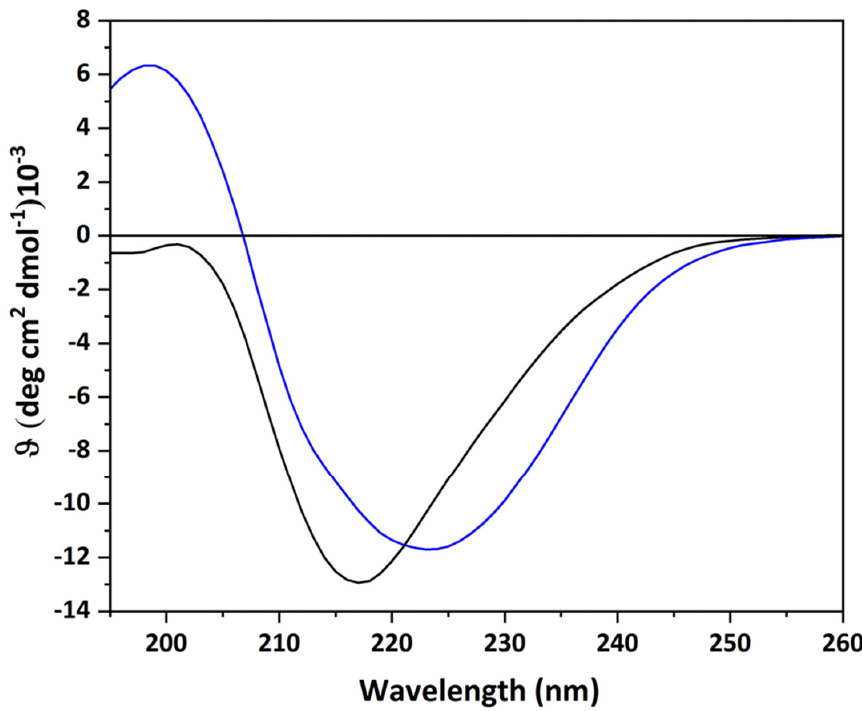
Figure 1. Far-UV CD spectra of Gal-1 (black line) and Gal-3 CRD (blue line).